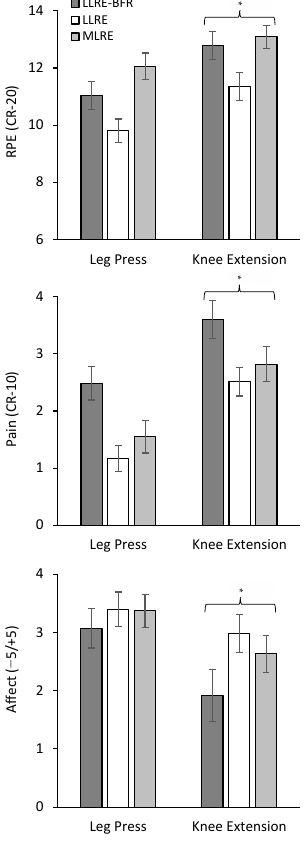
Figure 2. Mean RPE, pain and affect across sets 1–4 to display differences between conditions and exercises. * Significantly different to leg press. Brackets indicate differences. A significant condition main effect ( p = 0.031) was observed for affect during leg press with affect lower during LLRE-BFR compared to LLRE and MLRE ( p = 0.048, d = 0.5) (Fig- ure 1). For knee extension, significant condition ( p < 0.001) and time ( p < 0.001) main effects for affect were observed (Figure 1). Affect decreased from set 1–4 ( p < 0.001, d = 1.5) for all